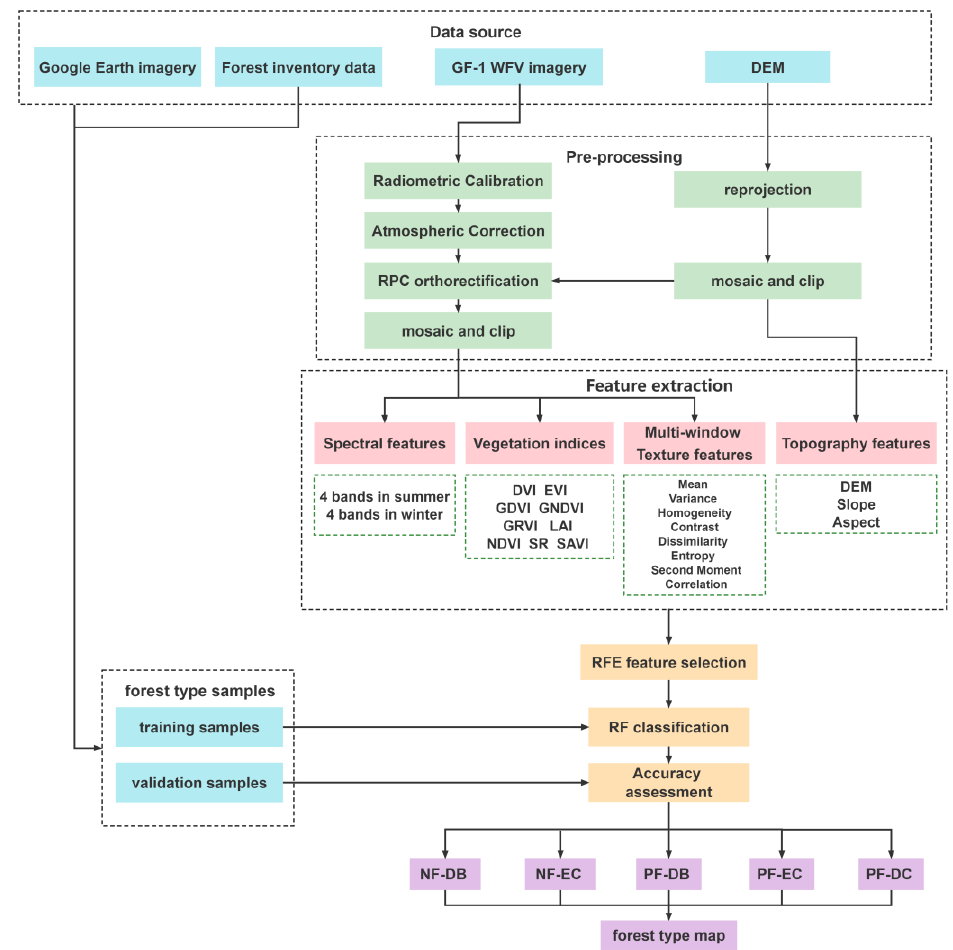
Figure 2. Methodological flowchart illustrating the important steps to produce the forest map.